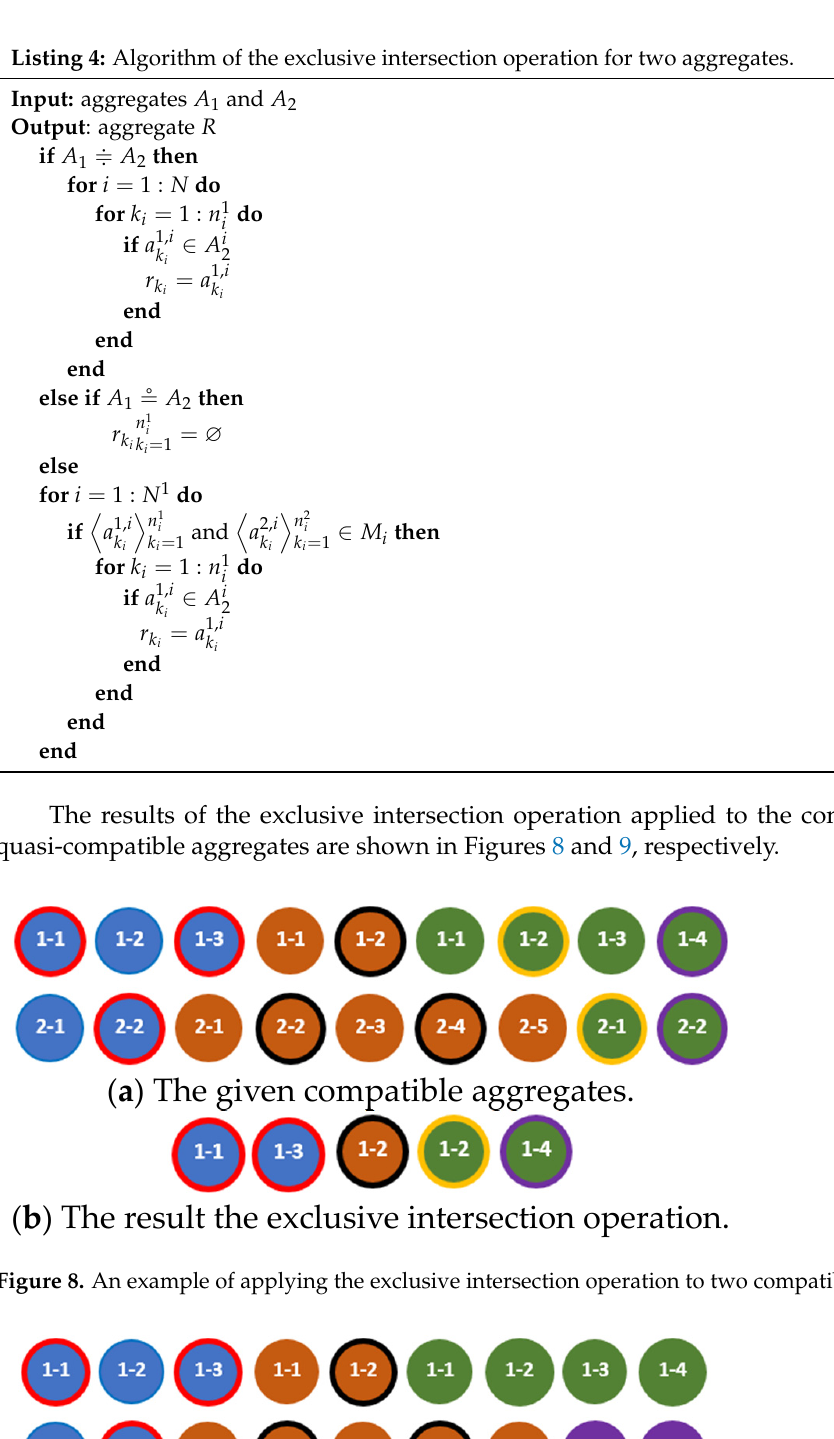
( a ) The given quasi-compatible aggregates.